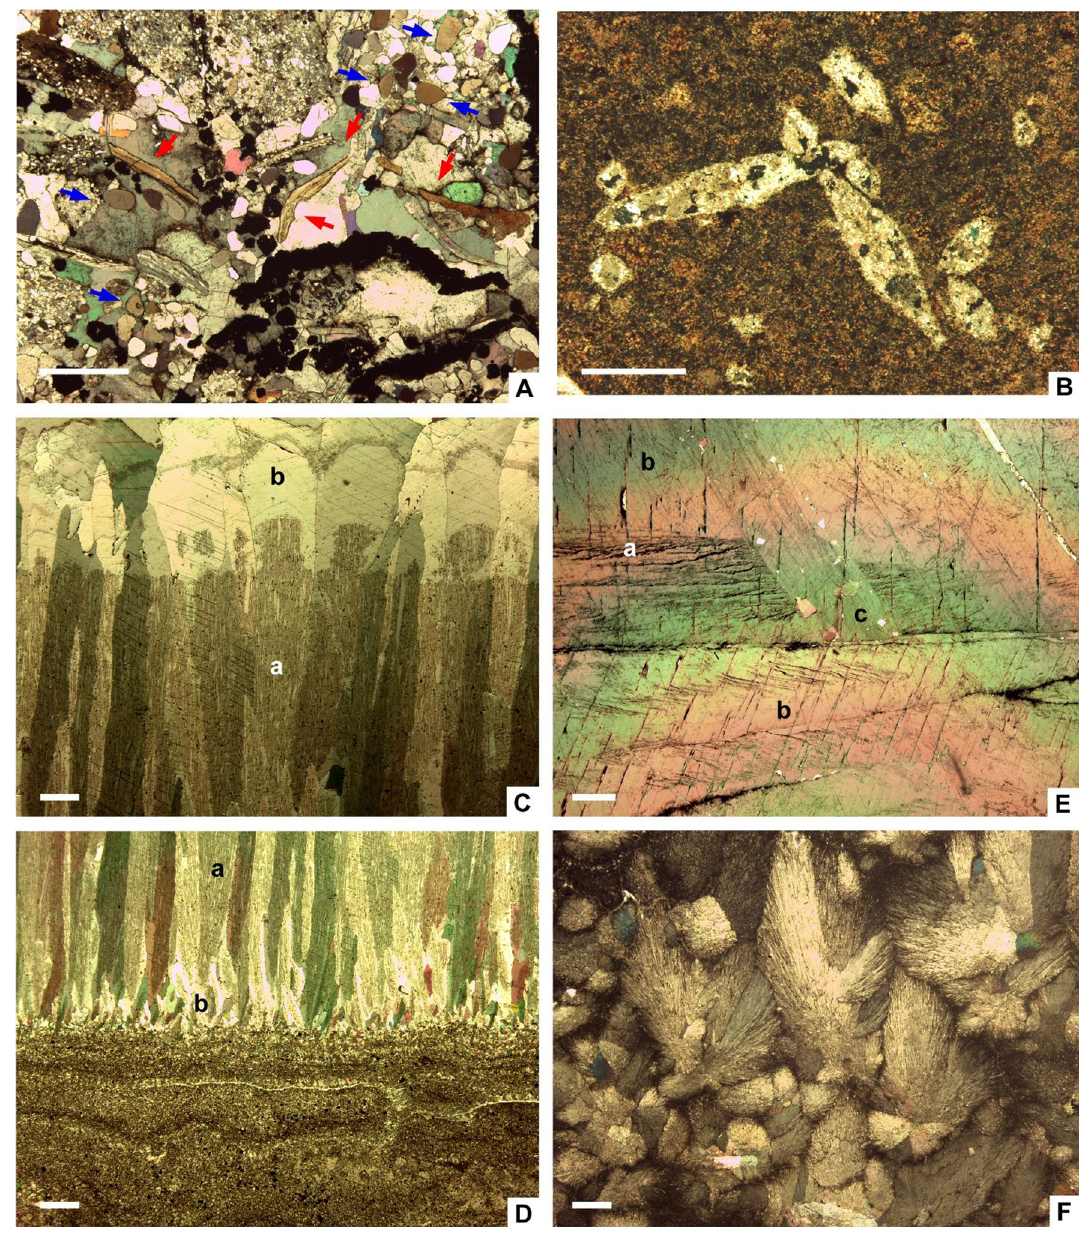
Figure 3. Thin-section photomicrographs (under crossed nichols) of in-situ calcite blankets at Bruddesta. ( A) Polymetallic basal breccia forming the Kakeled Limestone Bed rich in sulphide crusts and clasts (opaque minerals), subrounded quartz grains, calcite and apatite (marked by blue arrows) clasts, and linguliformean brachiopods (red arrows). ( B) Calcite pseudomorphs after anhydrite embedded in the limestone rich in zoned crusts of polymetallic sulphides. ( C,D) Arrangement of cloudy (a) and clean (b) calcite crystals in a crust. ( E) Crosscutting relationships between ca1 (a), ca2 (b) and ca3 (c) glendonitic phases. ( F) Feathery crystals of calcite forming the base of a crust; all scale bars = 1 exhibit a centripetal array of internal textures, ranging from (i) macrozoned or chevron-like textures displaying a millimetre-scale zoning of prismatic crystals at the core, to (ii) homogeneous (or unzoned) blades that finally grade peripherally to (iii) microgranular mosaics of calcite. Macrozoned blades are lath-shaped, inclusion-rich calcite crystals, either distinctly zoned or with a clear distinction from rim to core. They show undulatory extinc- tion under cross-polarized light and, under CL, they are dully luminescent with brightly luminescent outlines marking crystal contacts. Unzoned crystals form mosaics of sparry calcite infilling inter-crystalline pores, and are mostly non-luminescent. The granular texture consists of equant to bladed, sand-sized, calcite crystals, which are overgrown by variably sparry and spherulitic calcite cements and, under CL, the crystals are brightly luminescent, with some zonation marked by sharp changes from red to orange cements (Fig. 5C). The margins of